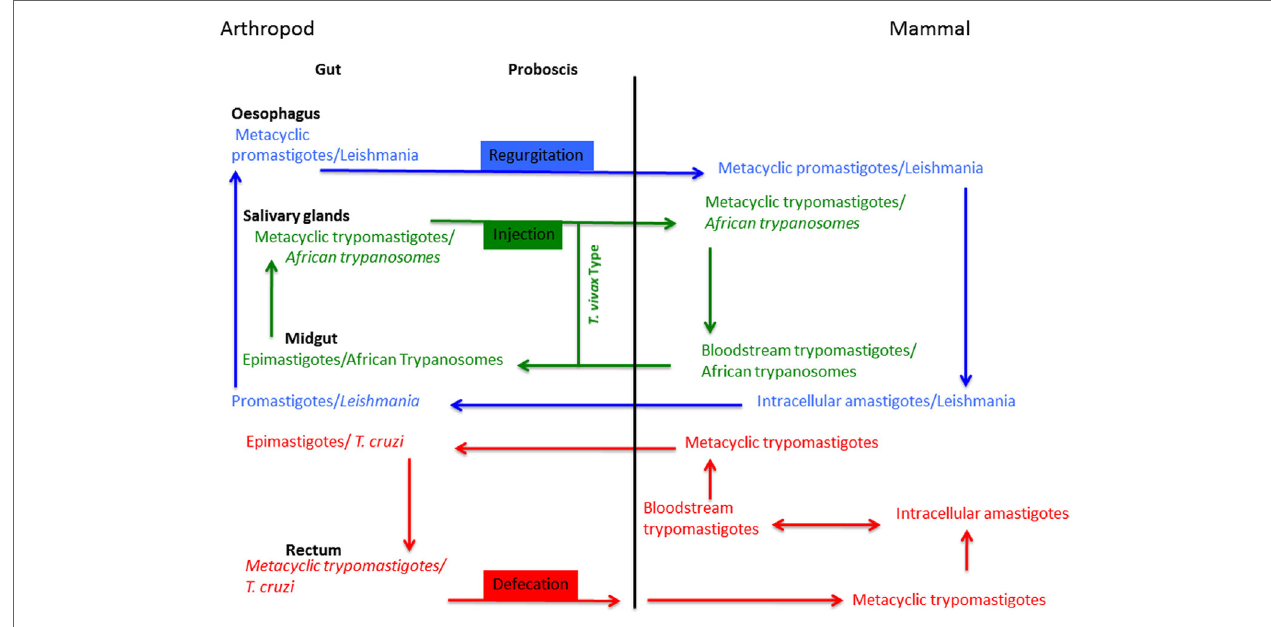
FiGURe 2 | Trypanosomatid parasites life cycles